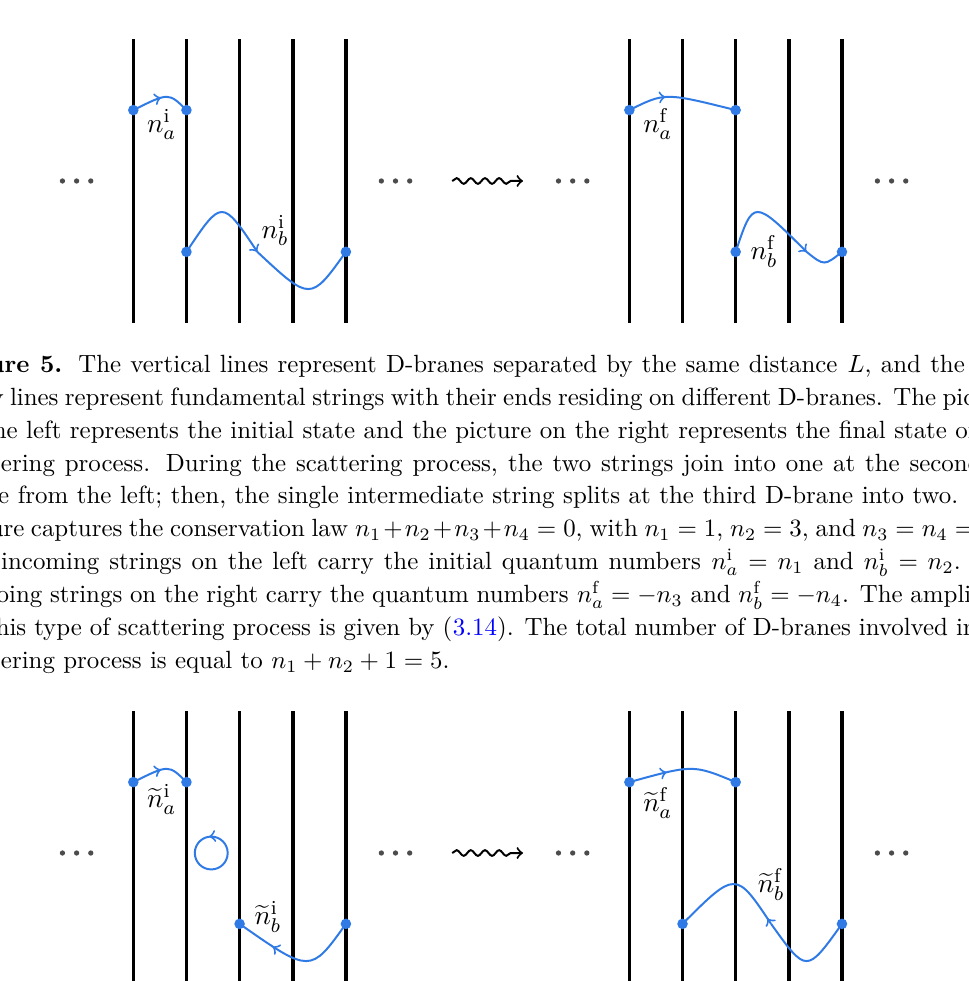
Figure 6. Scattering between two open strings that do not end on the same D-brane necessarily involve asymptotic closed string states. The figure with closed strings realizes the same conservation law for n i in figure 5 as follows. The incoming strings on the left carry the initial quantum numbers n i = n 1 and n i = n 3 . The outgoing strings on the right carry the final quantum numbers e e a b and n f = − n 2 . Nevertheless, the scattering process considered in this figure requires inserting an e b external closed string vertex operator, and is thus not computed by